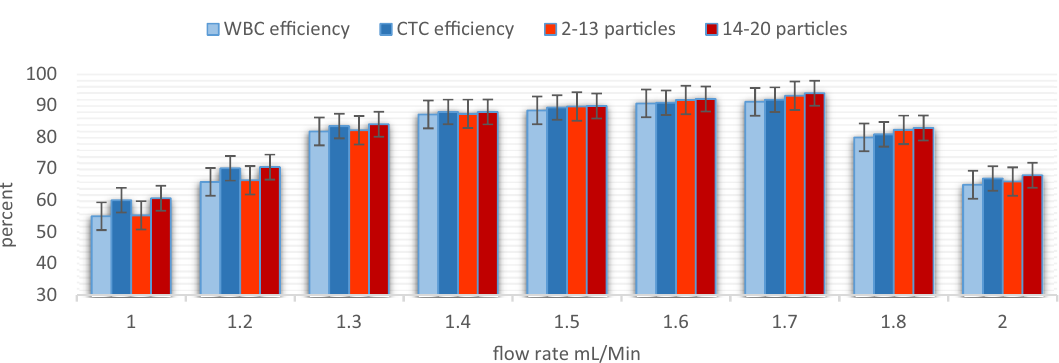
Figure 10. The comparison between real cells and rigid particles at various flow rate.